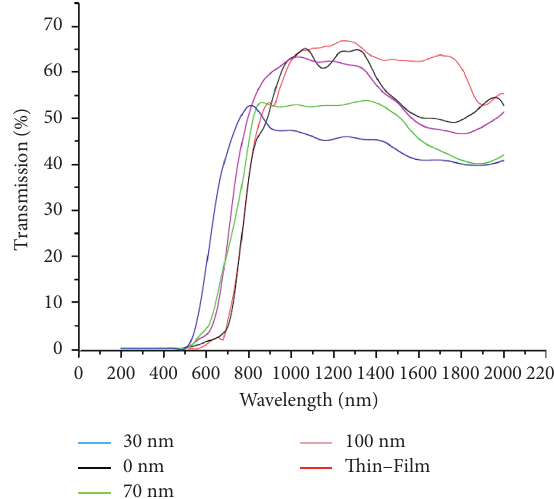
Figure 8: Transmission as a function of wavelength for thin-film (red curve), CdS shell thickness of 30nm (blue curve), CdS shell thickness of 70nm (green curve), CdS shell thickness (black curve), and CdS shell thickness of 100nm (cyan